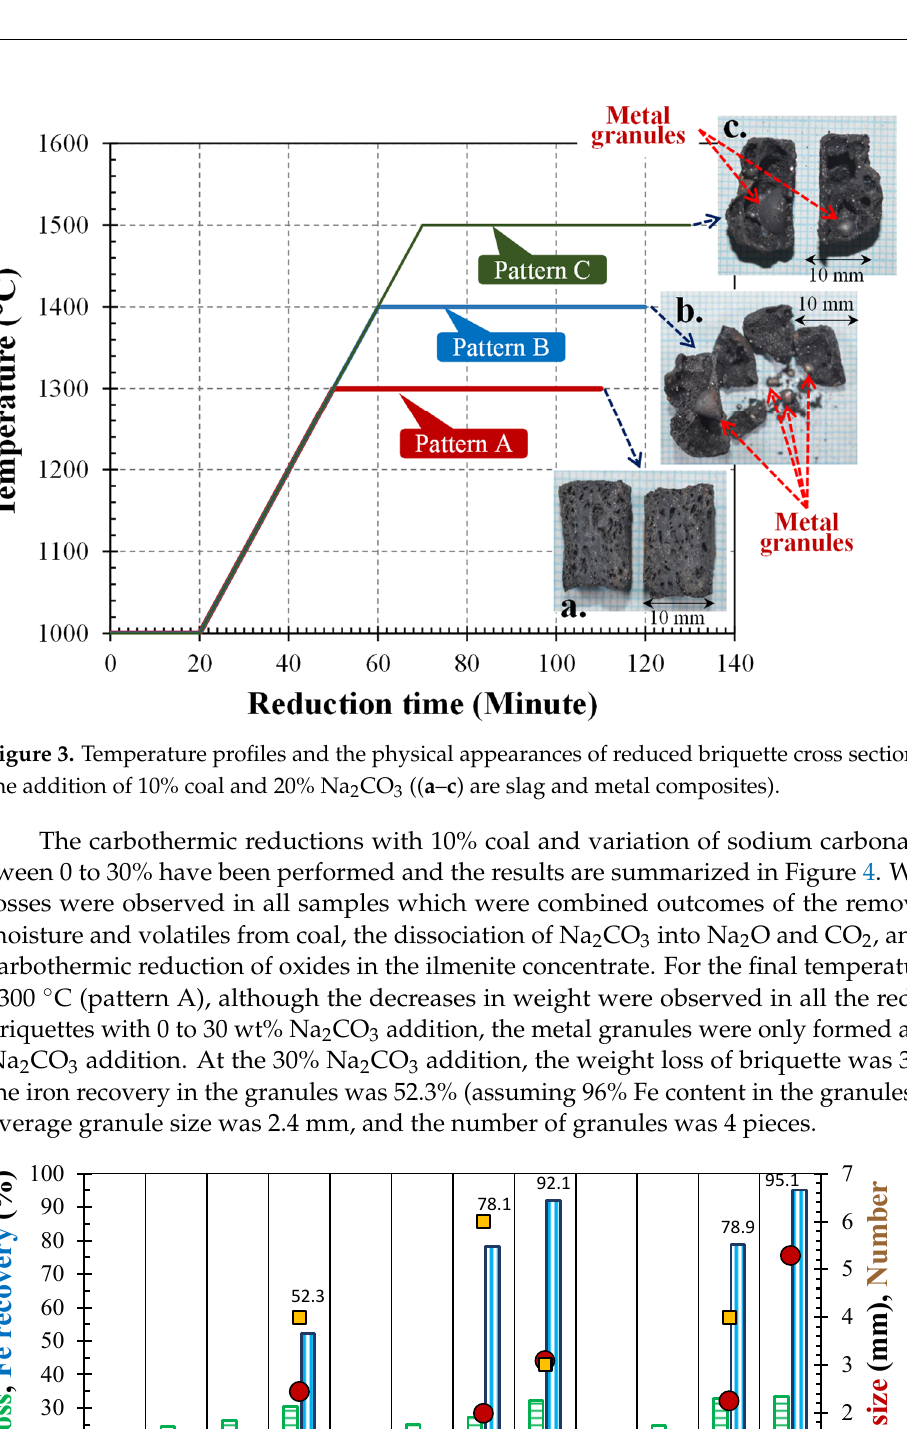
Figure 4. Effect of final temperature and addition of Na 2 CO 3 on weight loss, iron recovery in granules, granule diameter, and number of granules from the carbothermic reduction of the ilmenite concentrate at different Na 2 CO 3 addition, initial temperature of 1000 ◦ C, different final temperatures, and heating rate of 10 C/min.